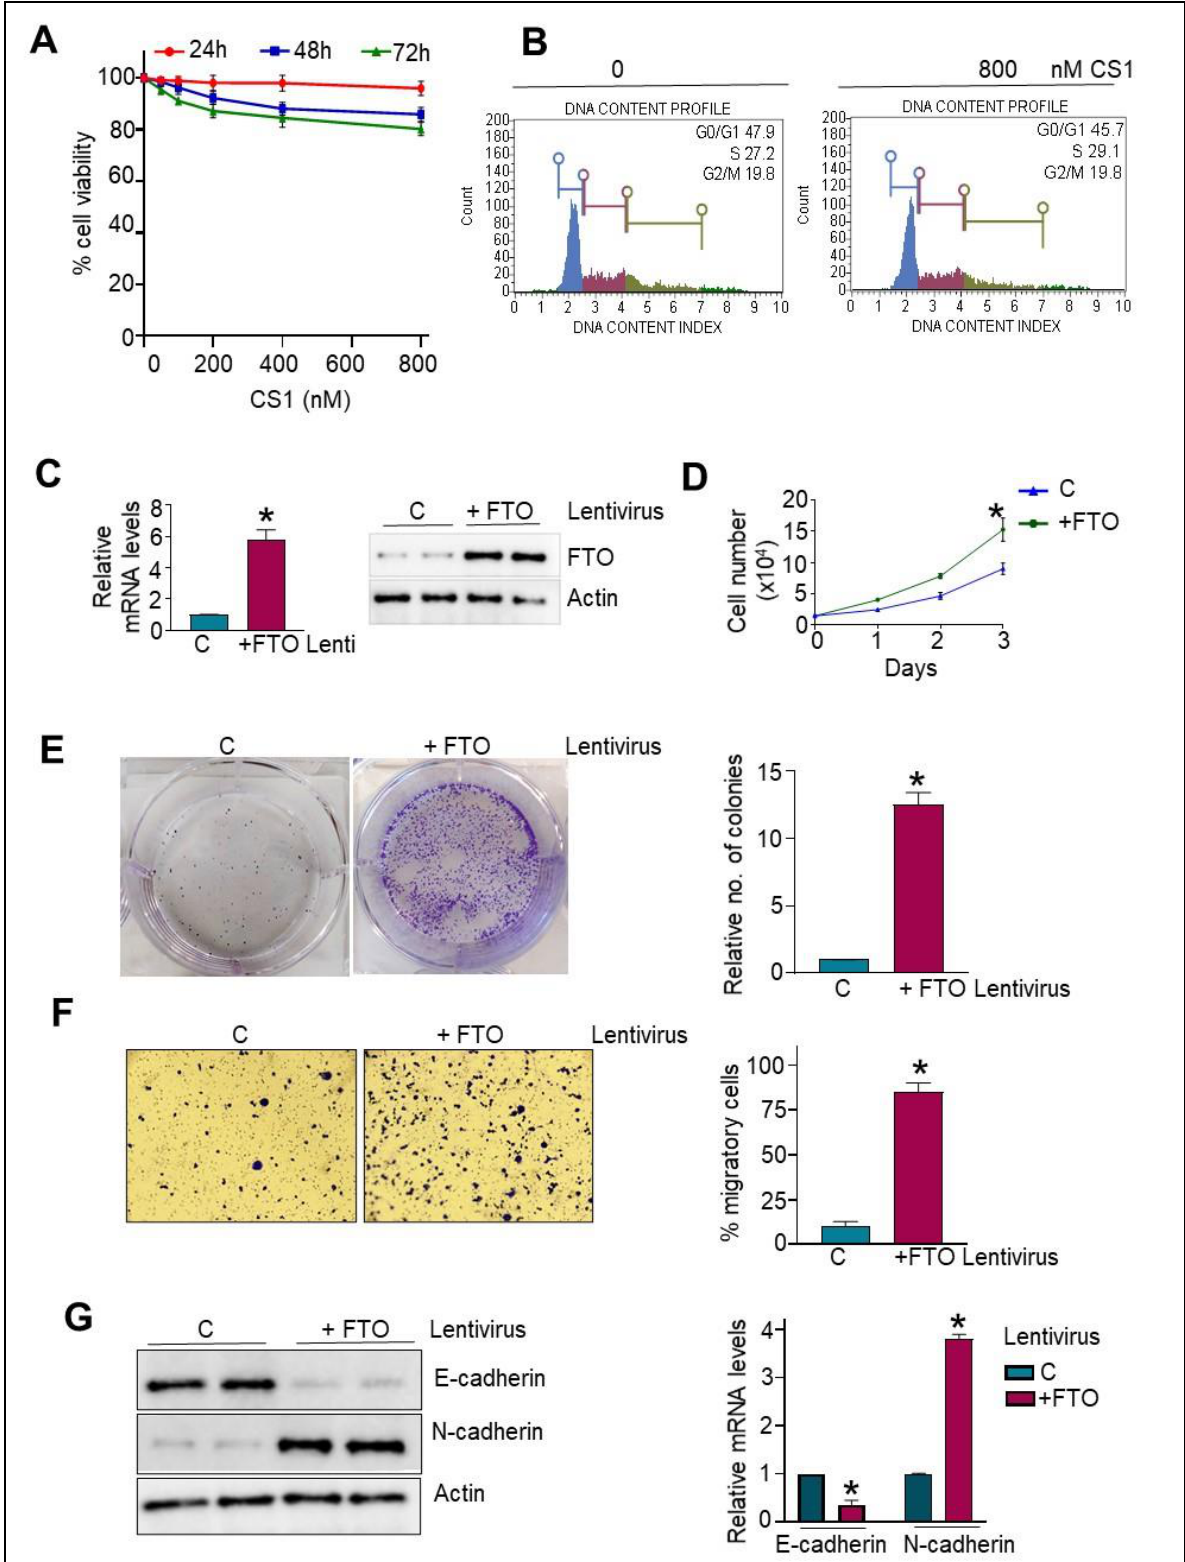
Figure 2. Normal HPDE cells remain insensitive to FTO inhibition, while overexpression confers proliferative and migratory advantage. ( A ) Normal HPDE cells were treated with different concentra- tions of CS1 for different time points (24, 48, and 72 h), and the CCK-8 assay determined the effect